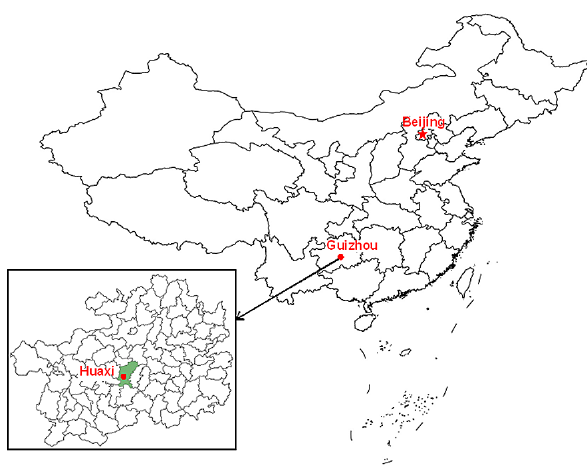
Figure 1. Geographic situation of the study area in China.